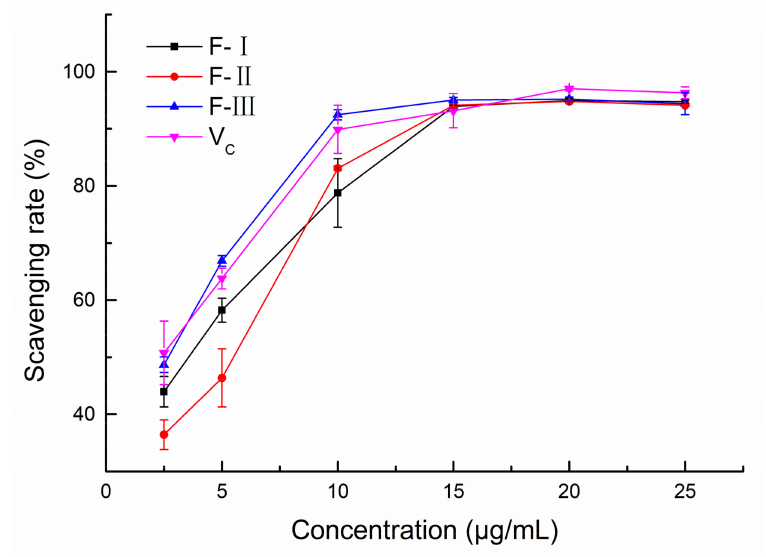
Figure 3. The capacities of three polyphenol fractions and vitamin C on 1,1-diphenyl-2-picryl-hydrazyl (DPPH) free